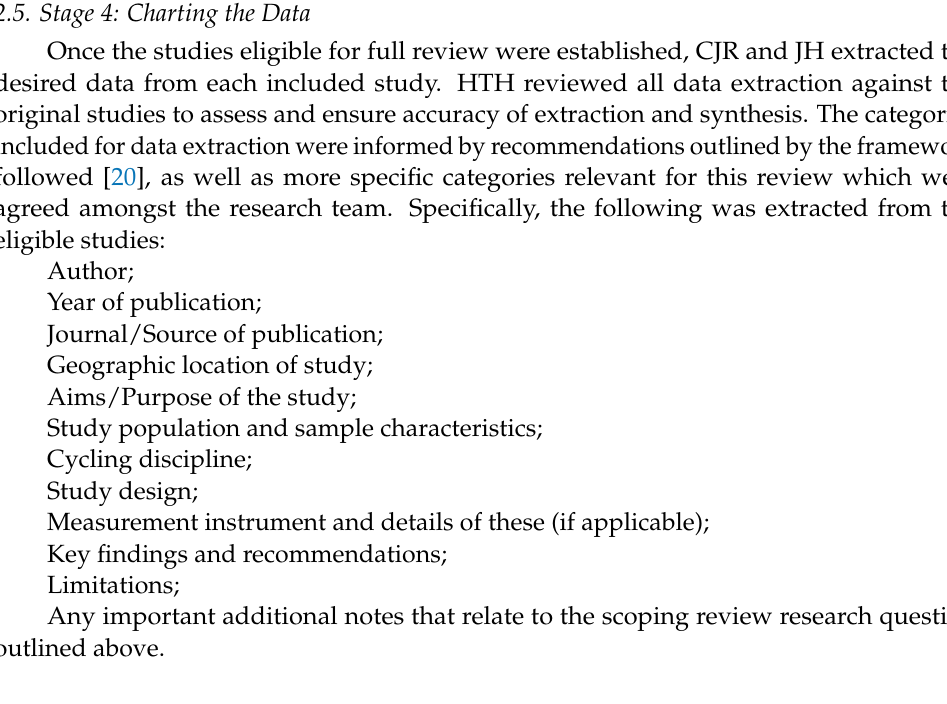
Figure 1. Flow diagram of search process.